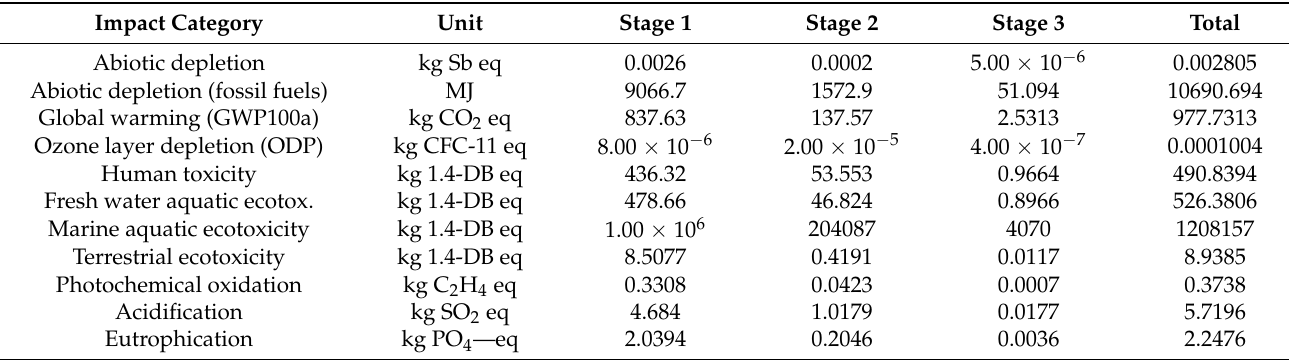
Table 18. Impacts generated by each stage of the activity of manufacturing 2-piece stoppers with dimensions of 24 × 44 by drilling.